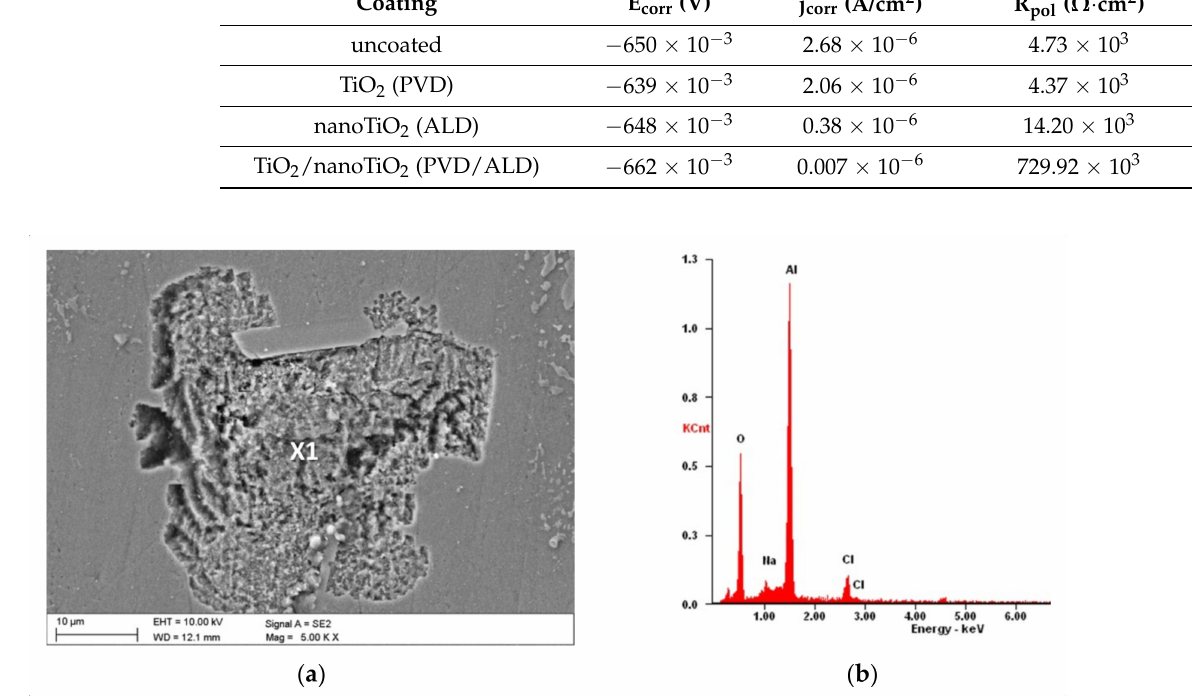
Figure 6. Morphology after an electrochemical examination of the sample coated by the nanoTiO 2 ALD coating: ( a ) SEM image and ( b ) X-ray energy-dispersive plot of the area X1 shown in ( a